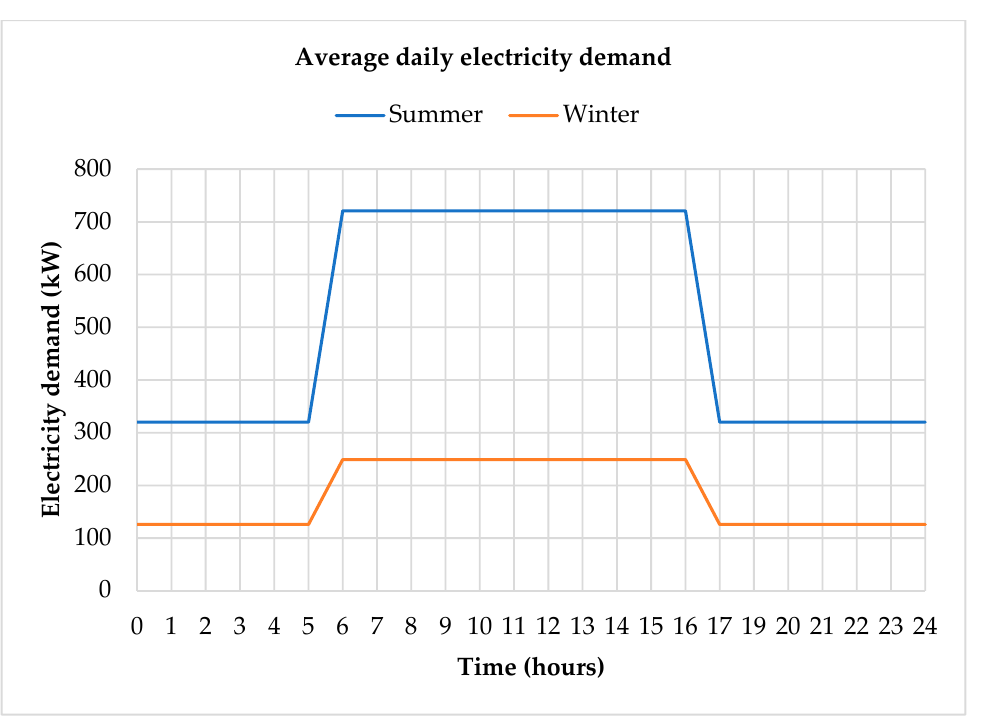
Figure 18. Average demand for electricity on a summer/winter day.